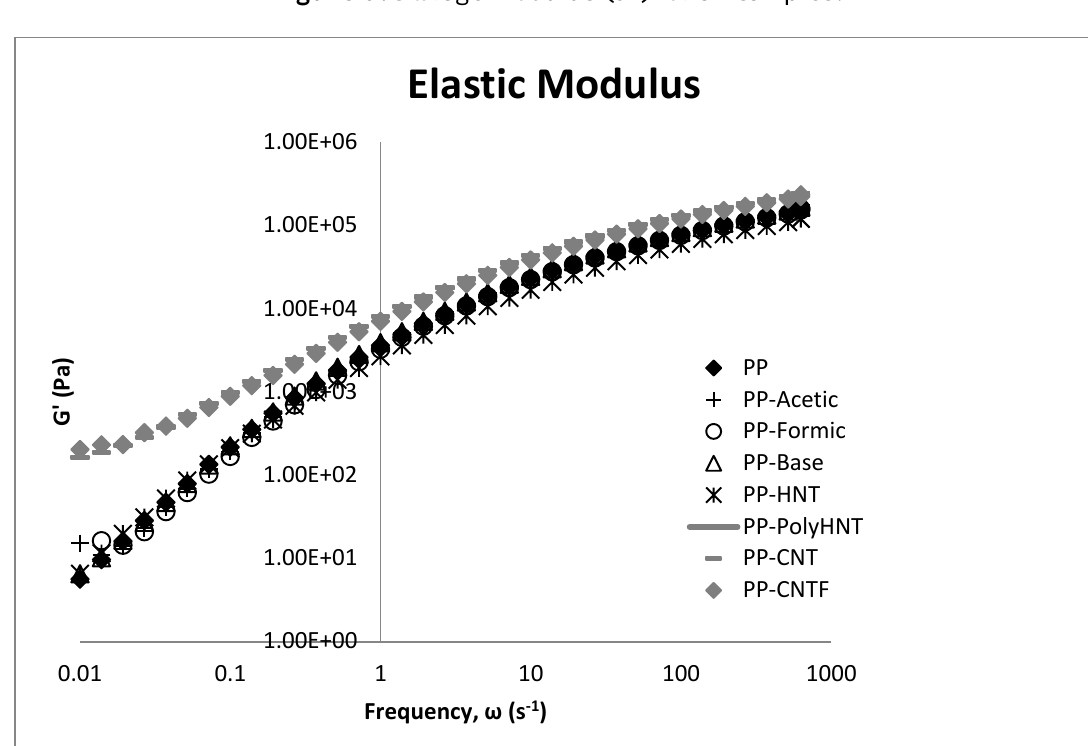
Figure 6. Storage modulus (G') for all